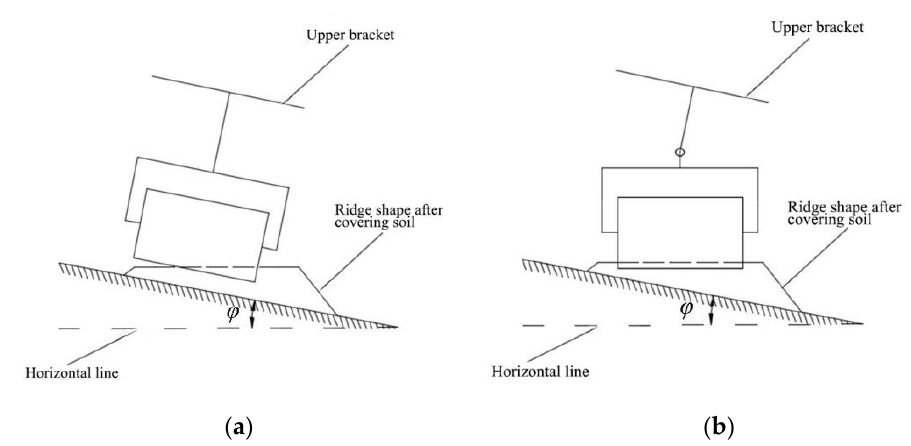
Figure 2. A motion sketch of the press device: ( a ) traditional press device; ( b ) the BPPD.